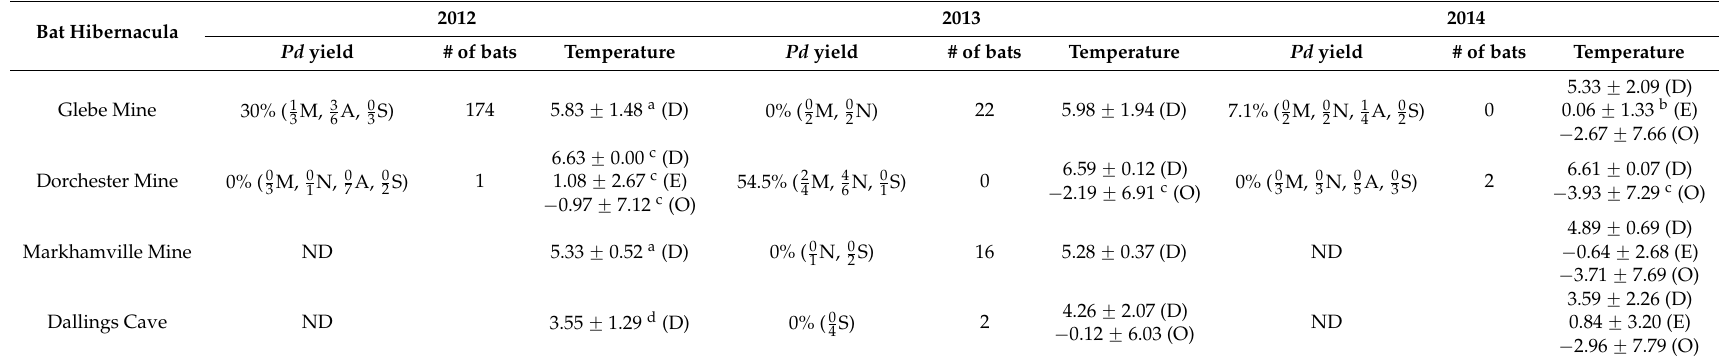
Table 3. The percentage of arthropods in bat hibernacula in New Brunswick, Canada from which Pseudogymnoascus destructans ( Pd ) was cultured over three years